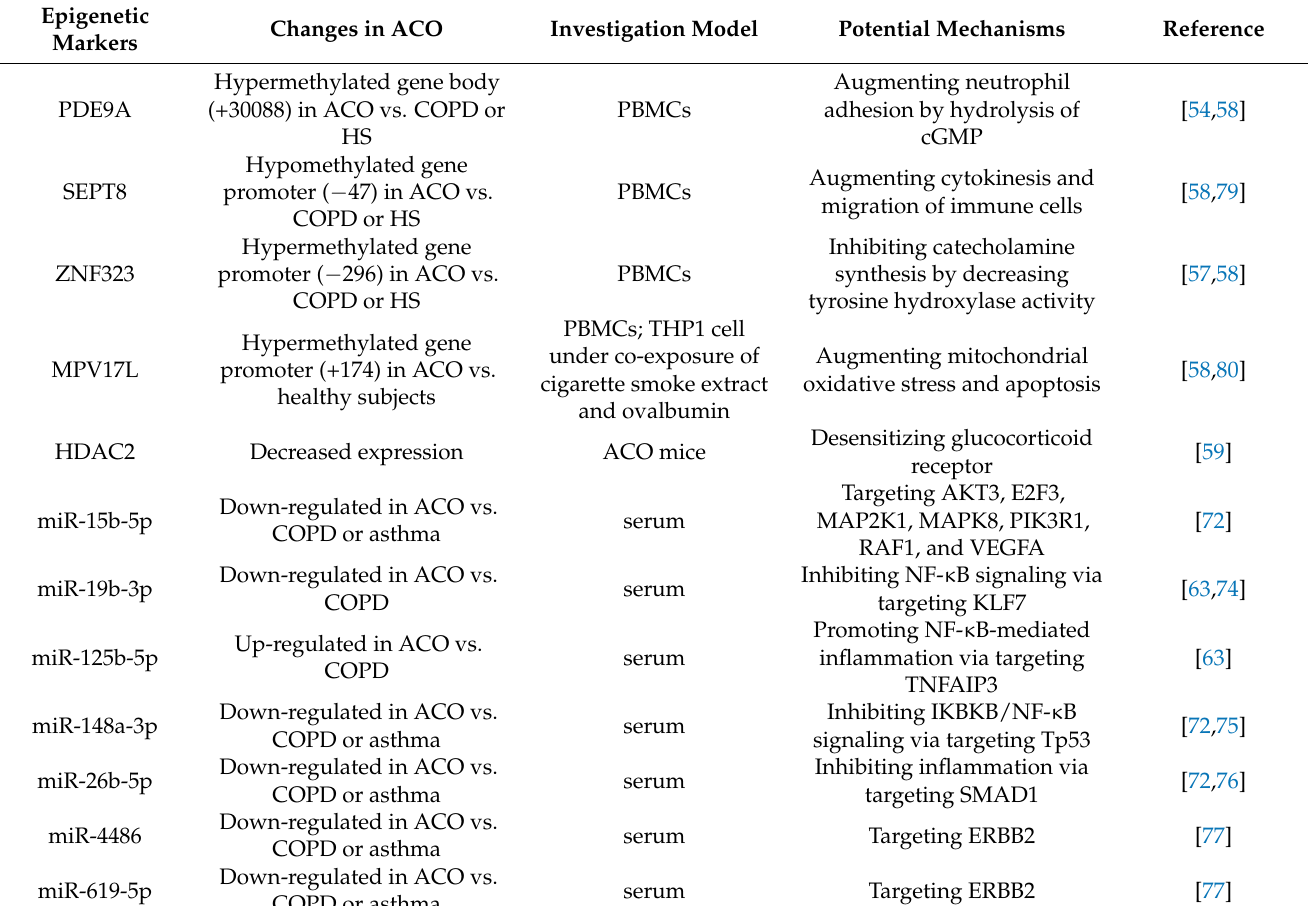
Table 2. Selected epigenetic markers and their potential mechanisms in the pathology of asthma and chronic obstructive pulmonary disease overlap